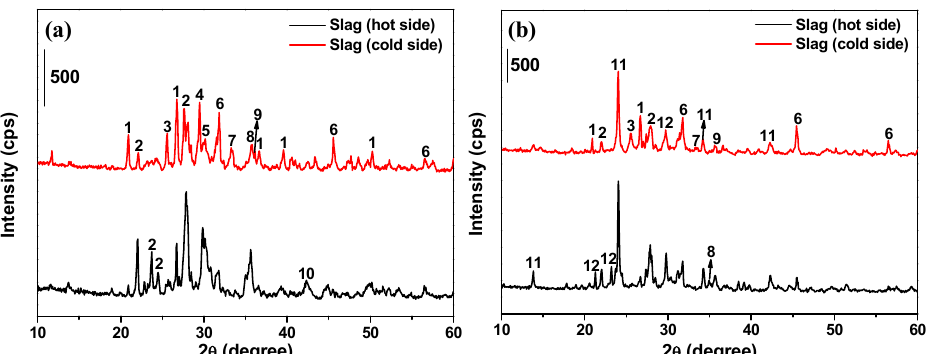
Figure 6. XRD patterns of slagging samples during hazardous waste incineration: ( a ) middle and rear sections of rotary kilns; ( b ) exit flue of second combustion chamber. The main crystalline phases are: (1) quartz (SiO 2 ), (2) labradorite (Ca 0.65 Na 0.35 (Al 1.65 Si 2.35 O 8 )), (3) anhydrite (CaSO 4 ), (4) calcium carbonate (CaCO 3 ), (5) diposide (CaMgSi 2 O 6 ), (6) halite (NaCl), (7) hematite (Fe 2 O 3 ), (8) magnesioferronite (MgFe 2 O 4 ), (9) magnetite (Fe 3 O 4 ), (10) magnesium iron oxide (MgO-FeO), (11) hauyne (Na 6 Ca 2 Al 6 Si 6 O 24 (SO 4 ) 2 ), (12) nepheline (KNa 3 (AlSiO 4 ) 4 ).